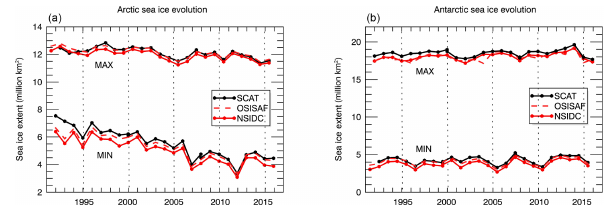
Figure 8. Evolution of minimum and maximum monthly sea ice extents from scatterometers (black line) and passive microwaves (continuous and dashed red lines) from 1992 to 2016 for the Arctic (a) and Antarctic (b) .